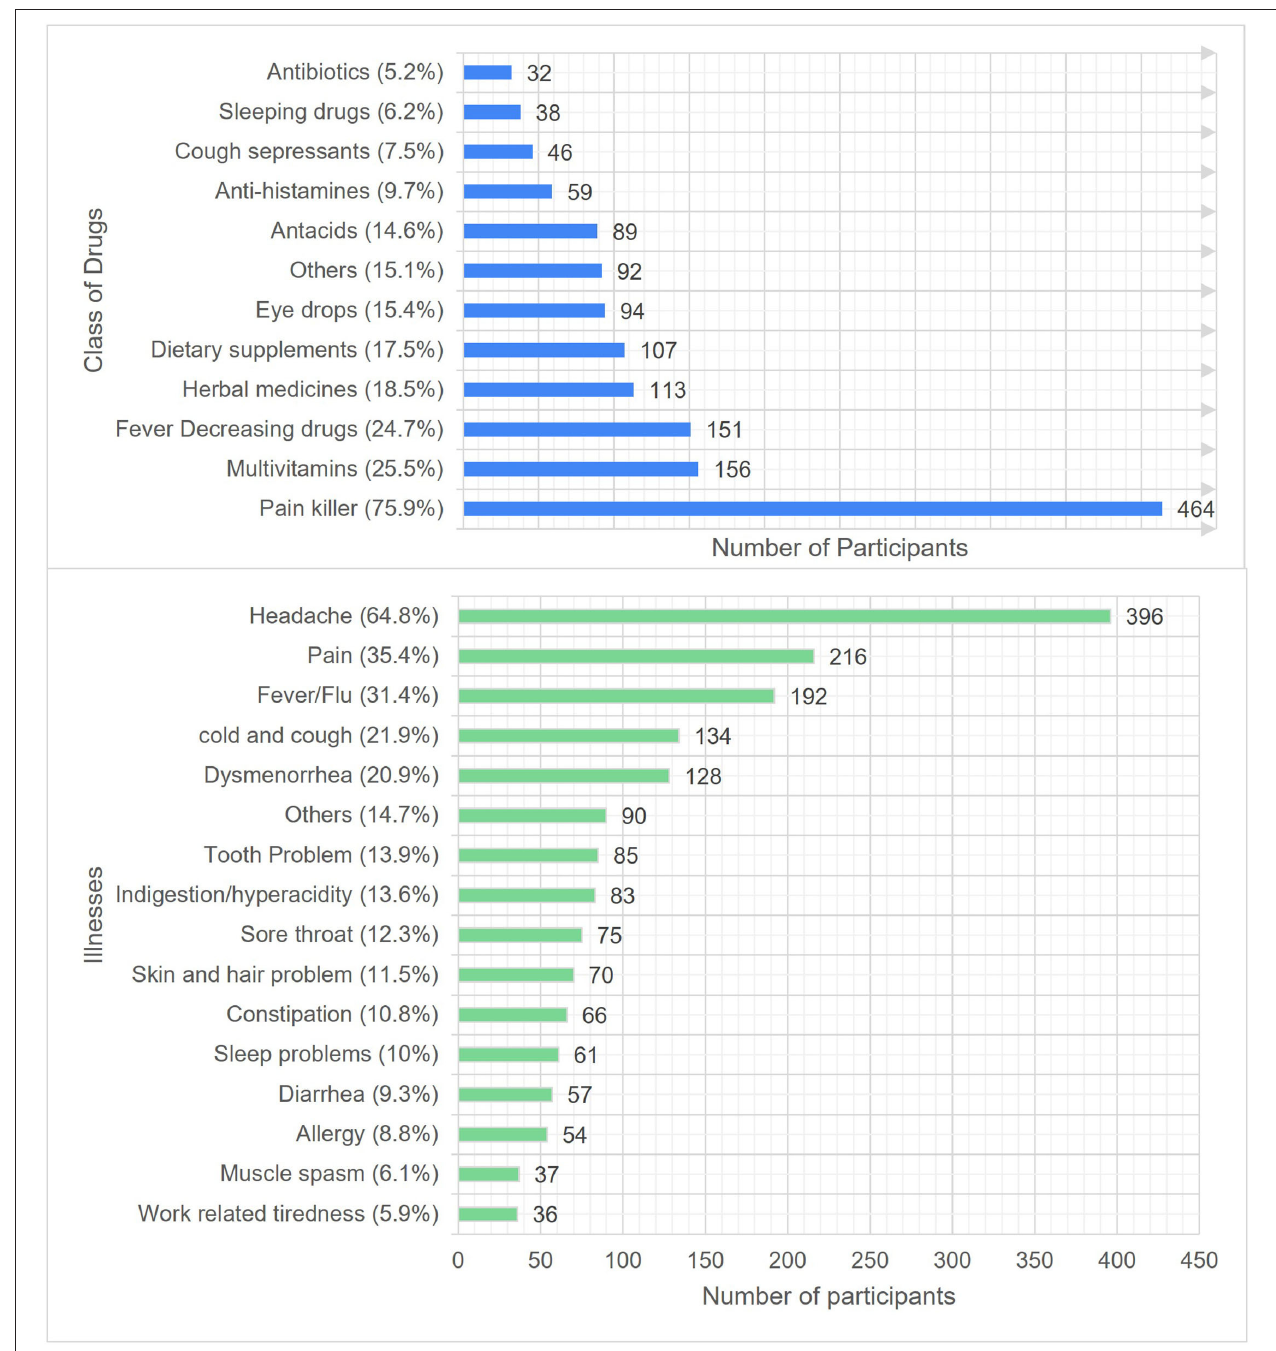
FIGURE 1 | Illnesses and classes of drugs used to practice SM during last 3